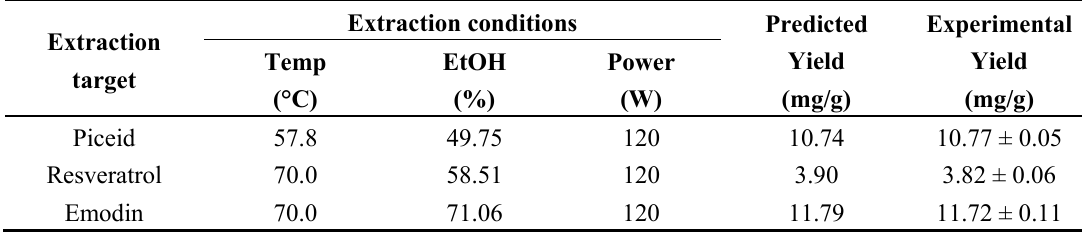
Table 3. Optimum conditions for the extraction yield of piceid, resveratrol, and